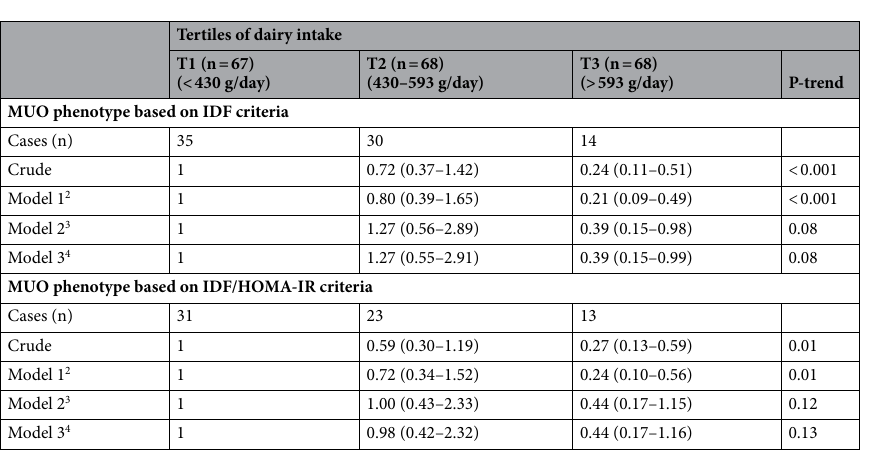
Table 2. Multivariate adjusted odds ratio (OR) and 95% confidence interval (CI) for MUO across energy- adjusted tertiles of dairy intake. 1 All values are odds ratios and 95% confidence intervals. 2 Model 1: Adjusted for age, sex, total energy intake, and fat intake (percent of energy). 3 Model 2: Additionally, adjusted for physical activity and socioeconomic status (parental education, parental job, number of family members, having car in the family, having computer/laptop, having personal room and having trip). 4 Model 3: Additionally adjusted for body mass index